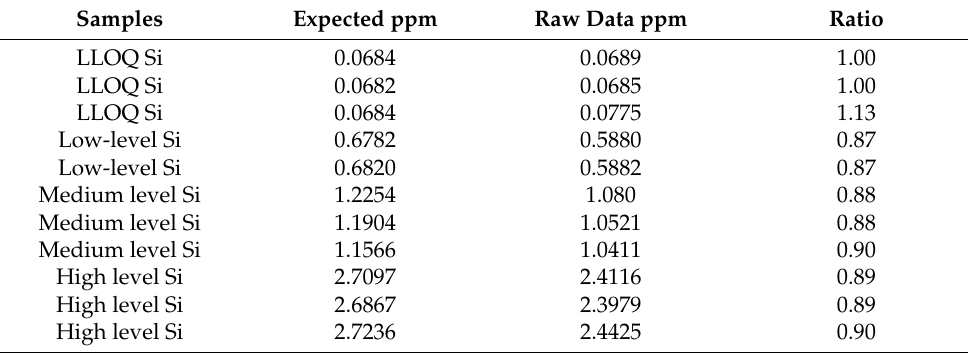
Table 4. Accuracy for chicken liver after digestion in HNO 3 /H 2 O 2 .